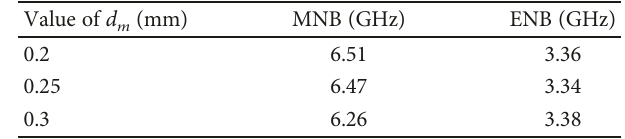
= d =5 mm, d =0.25mm, d = 0 25 mm, d =0.25 mm, g x y o c Table 2: E ff ect of d on MNB and ENB. m